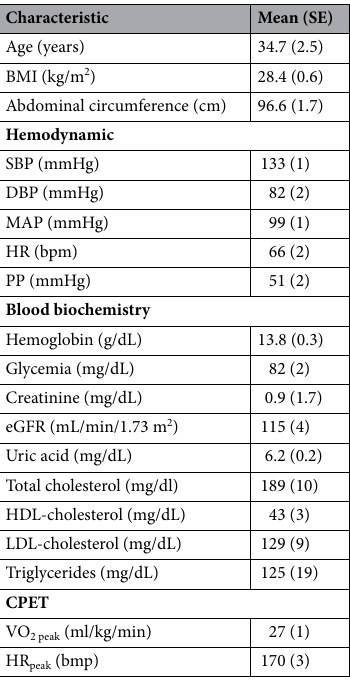
Table 1. Characteristics of the sample (n = 15). Values expressed as mean (SE). BMI, body mass index; SBP, systolic blood pressure (brachial); DBP, diastolic blood pressure (brachial); MAP, mean arterial pressure (brachial); HR, heart rate; PP, pulse pressure; CPET, cardiopulmonary exercise test; VO 2peak , peak of oxygen uptake. HR peak , maximum heart rate; eGFR, estimated glomerular filtration rate; HDL, high-density lipoprotein, LDL, low-density lipoprotein; CPET, cardiopulmonary exercise test; VO 2 peak , peak of oxygen consumption; HR peak , maximum heart